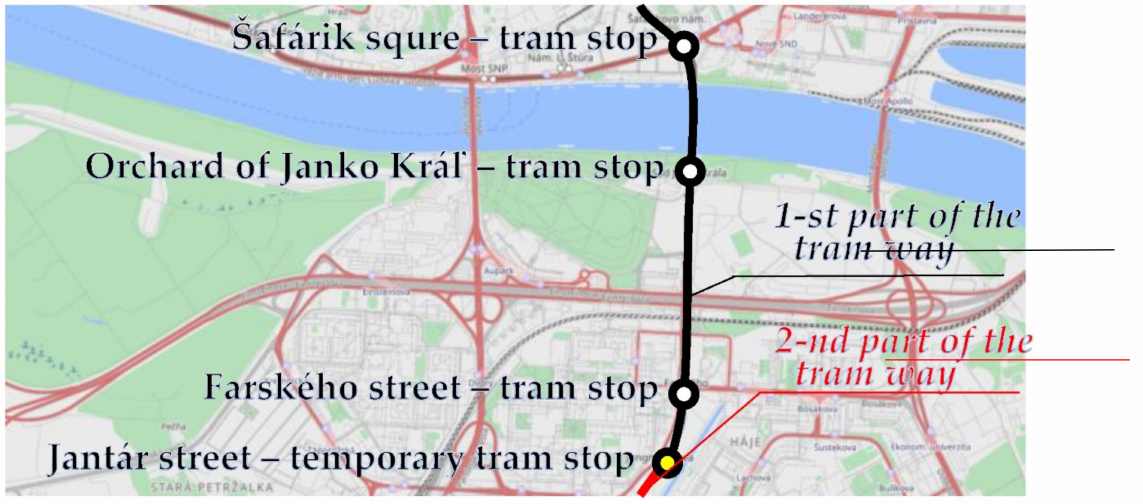
Figure 13. Route of the modernised tram line with the stop